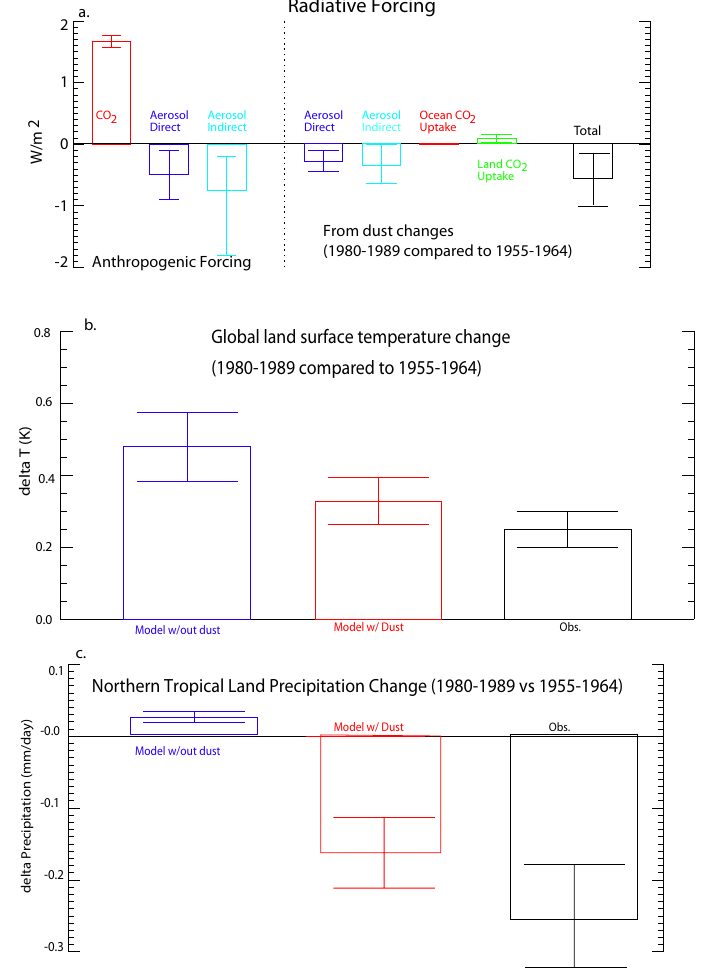
Fig. 4. Change in radiative forcing (W/m 2 ) from changes in anthropogenic forcing ( a , left panel) as estimated from the IPCC for carbon dioxide (red) (Forster, 2007), aerosol direct forcing (blue) and indirect forcing (cyan), and for (a, right panel) dust changes as estimated here for the period 1980–1989 (dusty) compared to 1955–1964 (non dusty). Dark blue indicates direct radiative forcing from dust changes, cyan indicates indirect radiative forcing from dust changes, red indicates changes in radiative forcing from ocean uptake of carbon dioxide due to changes in dust, and green indicates changes in radiative forcing from land uptake of carbon (which is opposite in sign to the other forcings). The total radiative forcing from dust changes between 1980–1989 and 1955–1964 is shown in black. The uncertainty estimates are calculated in Sect. 4. Change in globally averaged surface temperature between the dusty time period (1980–1989) compared to the non-dusty time period (1955–1964) for the model simulations (over land) without dust (blue) with dust (red) and observations (black) (Brohan et al., 2006) (b) . Change in Northern Hemisphere Tropical precipitation over land (0–20 ◦ N) between the dusty and non-dusty time period in the model without dust (blue), the model with dust (red) and observations (black) (Dai et al., 2004) (c) . The uncertainty envelope in radiative forcing (a) comes from the uncertainty analysis in the Sect. 4, while in the uncertainty envelopes in the temperature and precipitation (b and c) represent interannual variability (and ensemble members for the